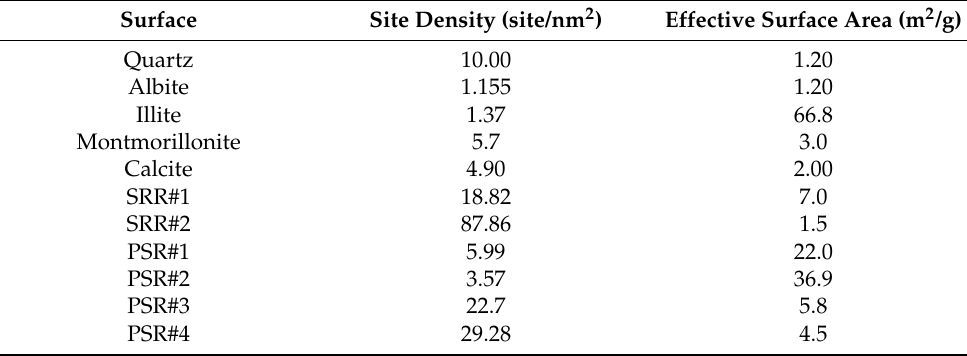
Table 5. Properties of the minerals and reservoir rocks.